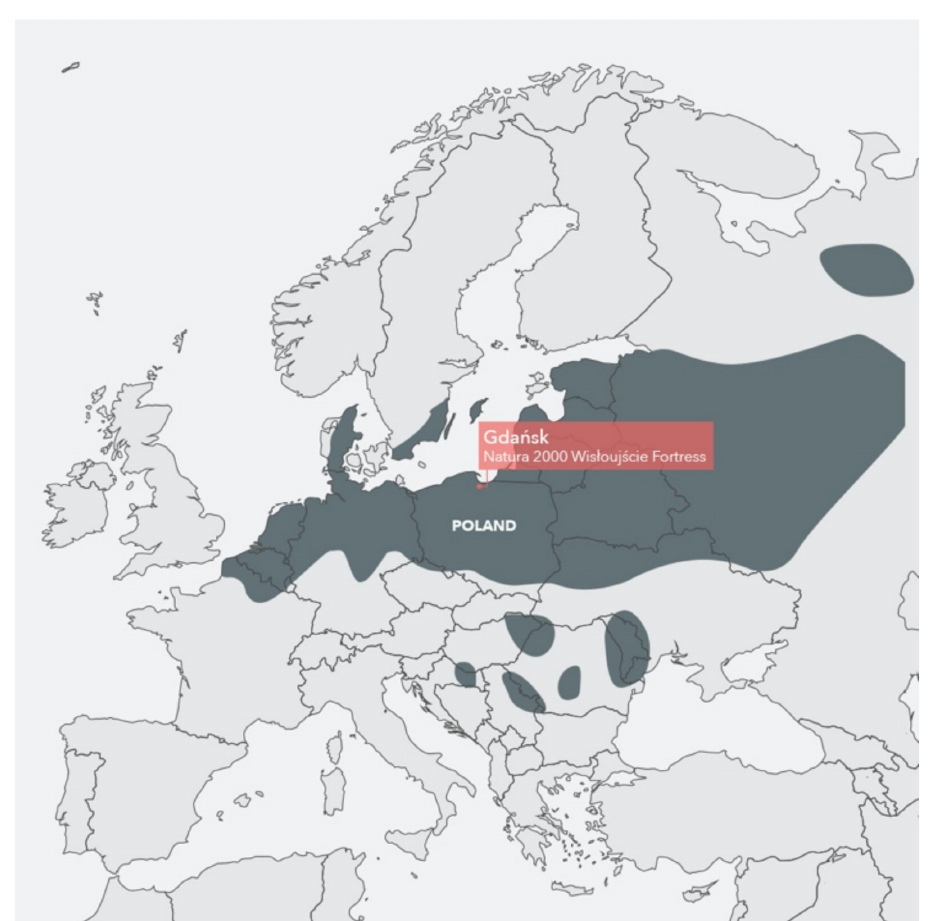
Figure 4. Distribution of the pond bat ( Myotis dasycneme ) in Europe, author’s elaboration based on